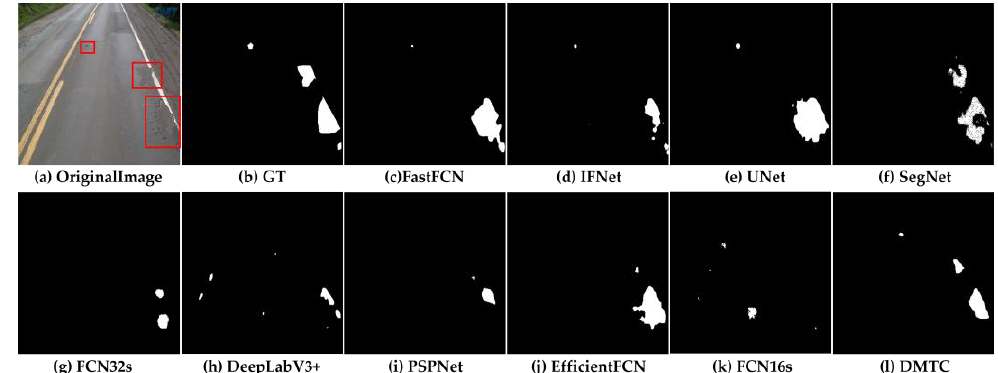
Figure 8. Visual comparison of the results of a series of segmentation methods for medium potholes